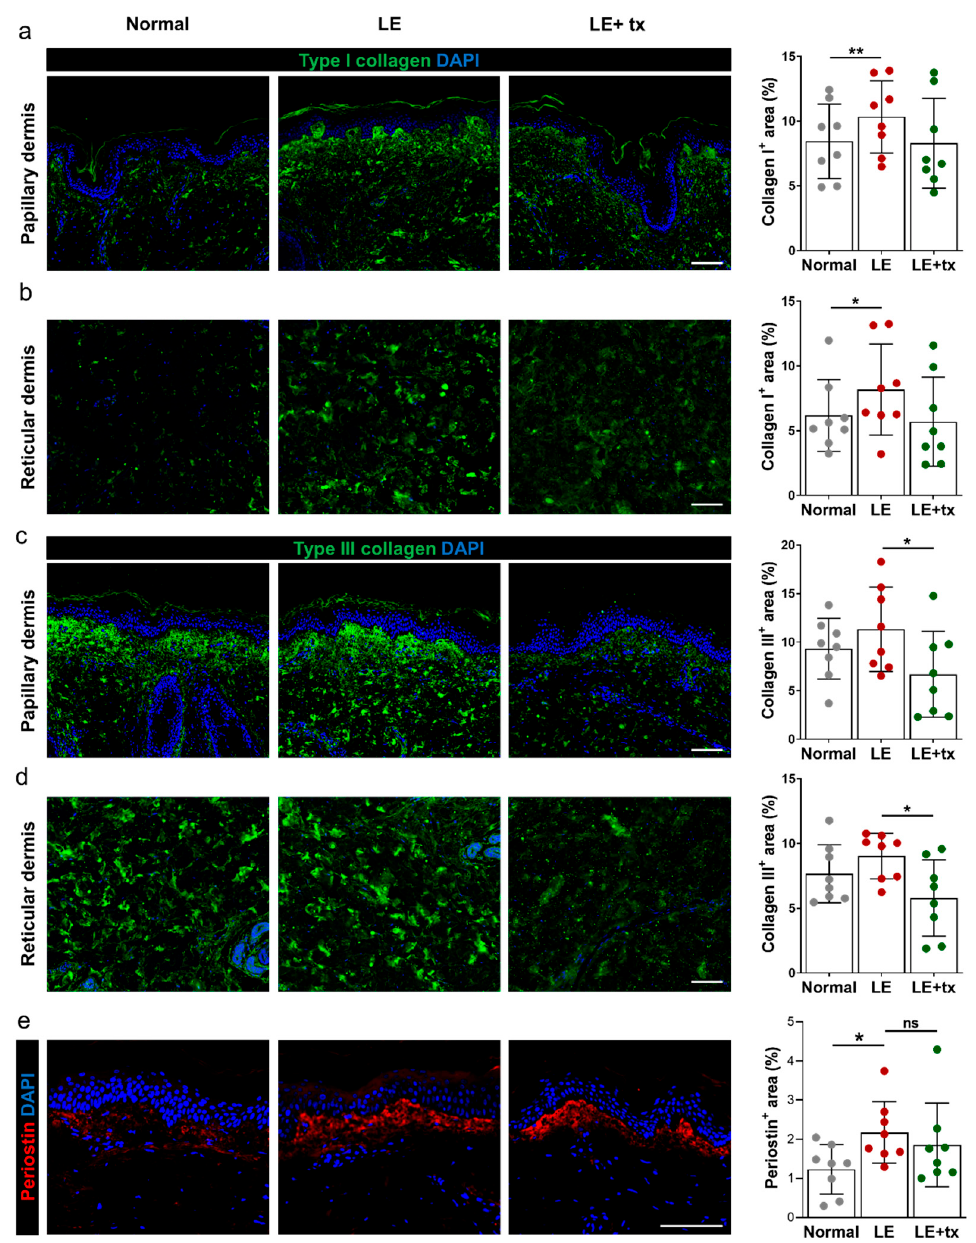
Figure 4. Treatment with QBX258 decreases type III collagen deposition in lymphedematous tissues. Fibrosis after QBX258 treatment. ( a , b ) Representative immunofluorescent staining (left panels) and quantification (right panel) in normal, LE, LE + tx biopsy specimens for DAPI (blue) and type I collagen (green) in the papillary ( a ) and reticular ( b ) dermis. ( c , d ) Representative immunofluorescent staining (left panels) and quantification (right panel) in normal, LE, LE + tx biopsy specimens for DAPI (blue) and type III collagen (green) in the papillary ( c ) and reticular ( d ) dermis. ( e ) Representative immunofluorescent staining (left panels) and quantification (right panel) of normal, LE, LE + tx biopsy specimens for DAPI (blue) and periostin (red). Scale bar: 50 μ m; * p < 0.05; ** p < 0.01.